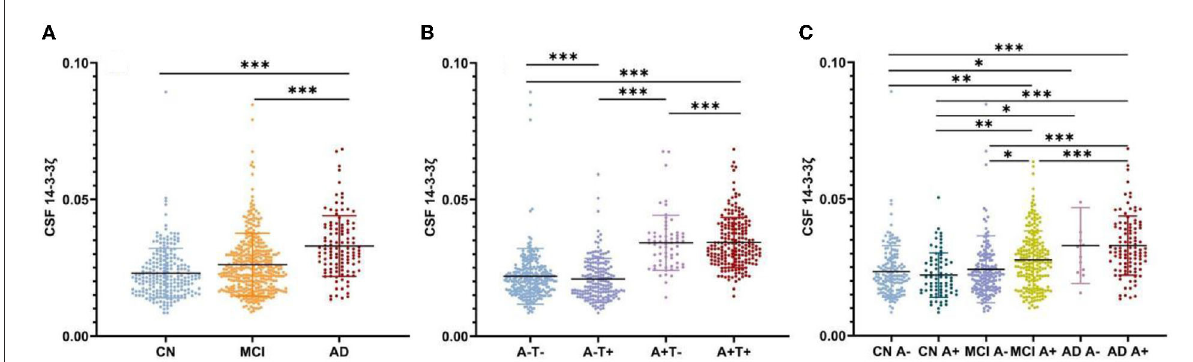
FIGURE1 Cerebrospinal fluid (CSF) 14-3-3 ζ concentrations in different groups. (A) CSF 14-3-3 ζ concentrations in cognitive normal (CN), mild cognitive impairment (MCI), and Alzheimer’s disease (AD). (B) CSF 14-3-3 ζ concentrations by AT(N) classification. (C) CSF 14-3-3 ζ concentrations in different clinical diagnosis and beta-amyloid (A β ) status. * p < 0.05, ** p < 0.01, *** p <